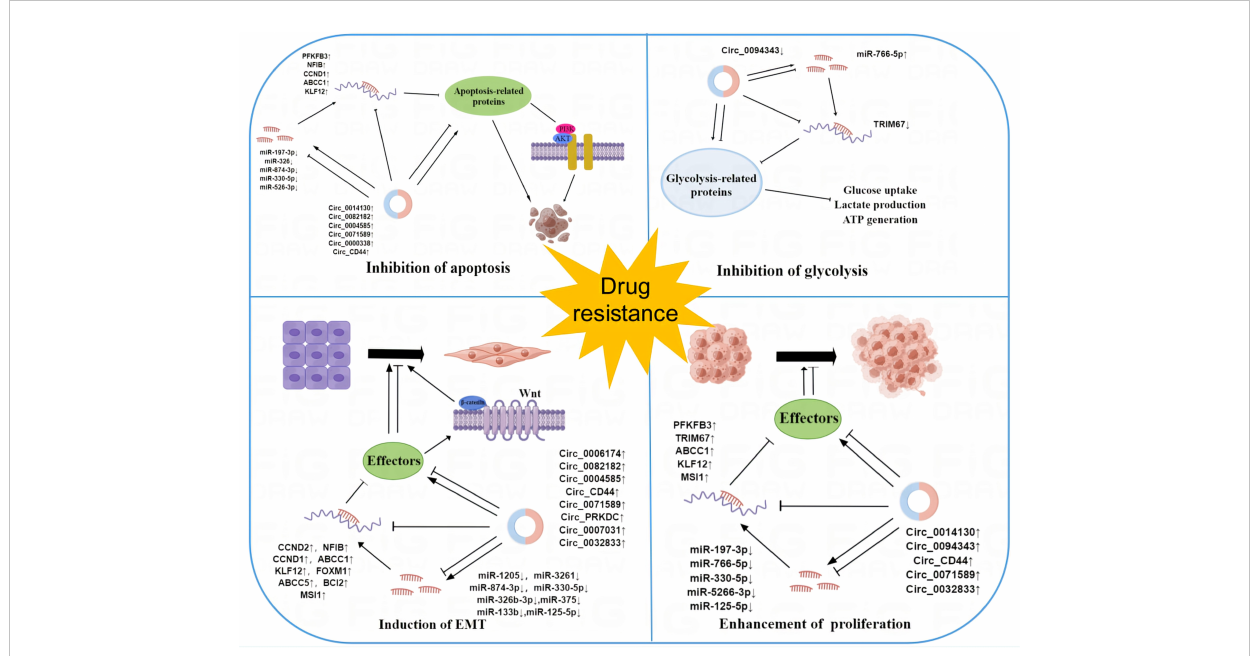
FIGURE 3 The mechanism of circRNAs in cancer drug resistance. Dysregulation of circRNAs contributes to the development of cancer resistance by regulating a variety of cellular processes in cancer cells, such as apoptosis, EMT, glycolysis, and cell